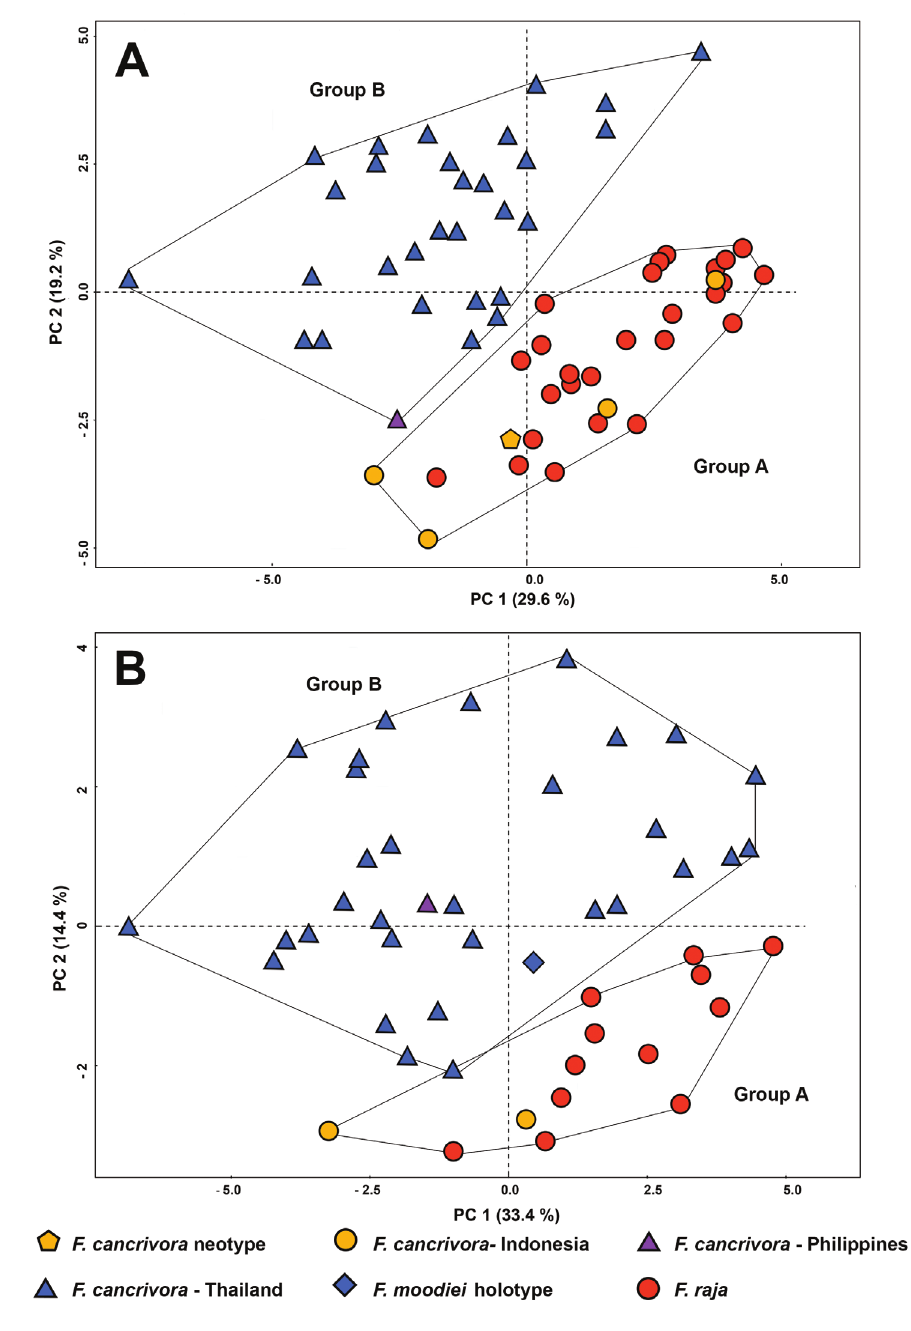
Figure 3. Principal component analysis of morphological measurements from males ( A ) and females ( B ) of Fejervarya cancrivora , F. moodiei , and F. raja